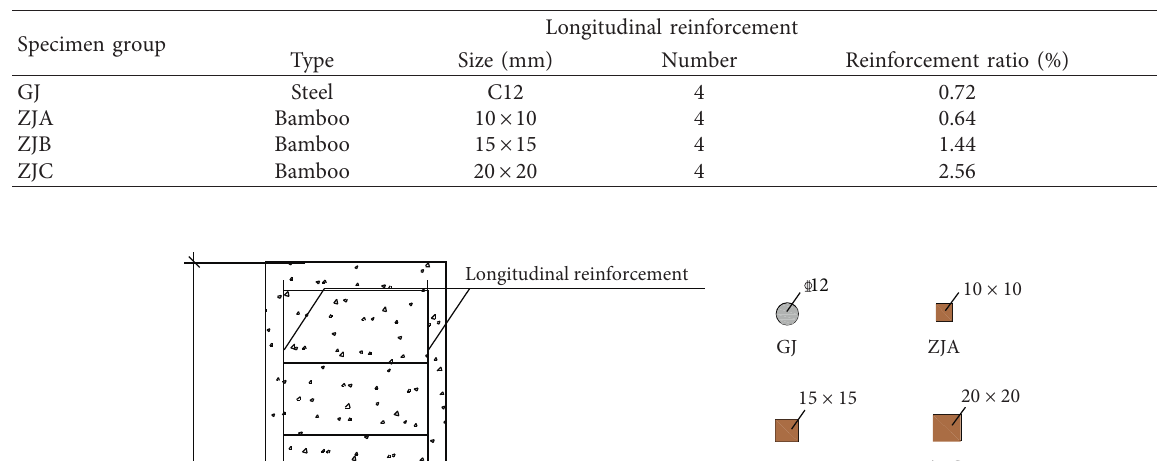
Table 1: Properties of specimens.